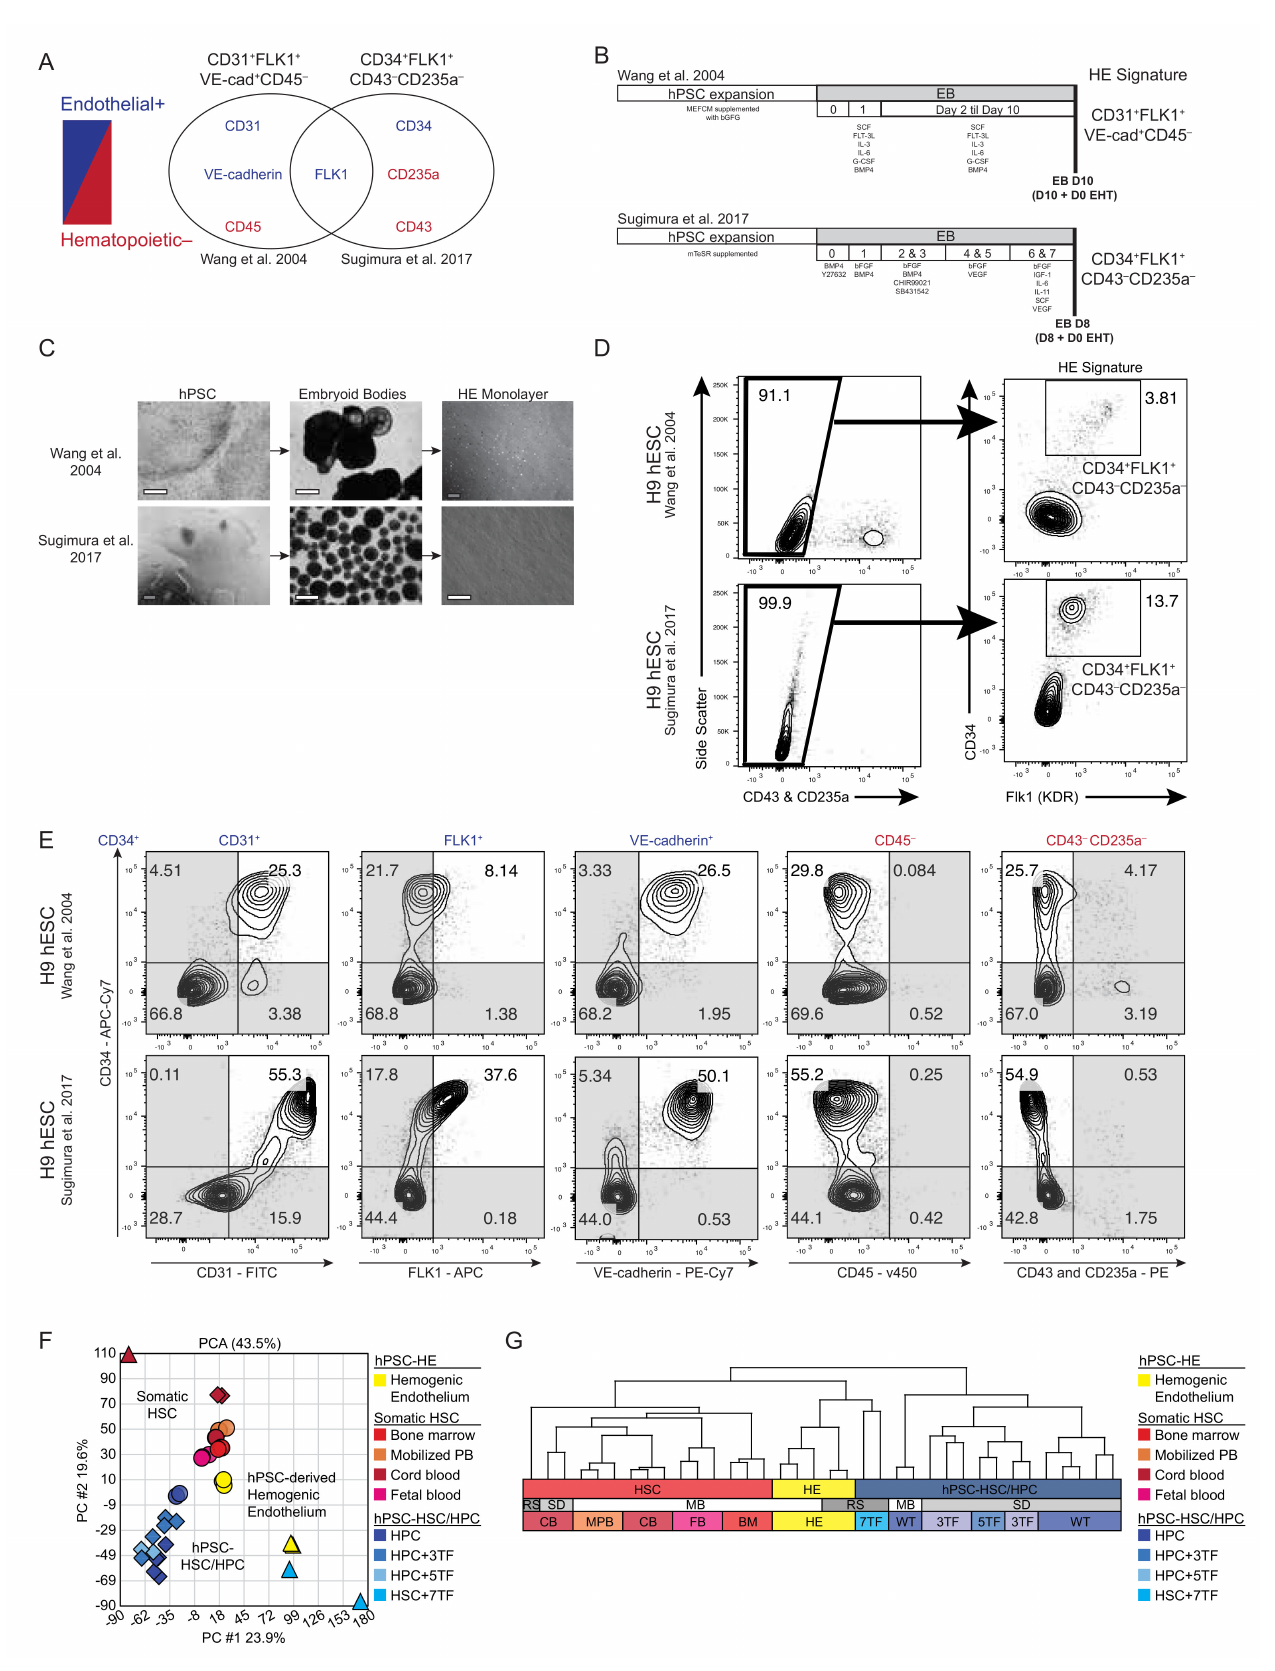
Figure 1. Co-expressed surface markers of hPSC-derived hemogenic endothelium. ( A ) Overlap